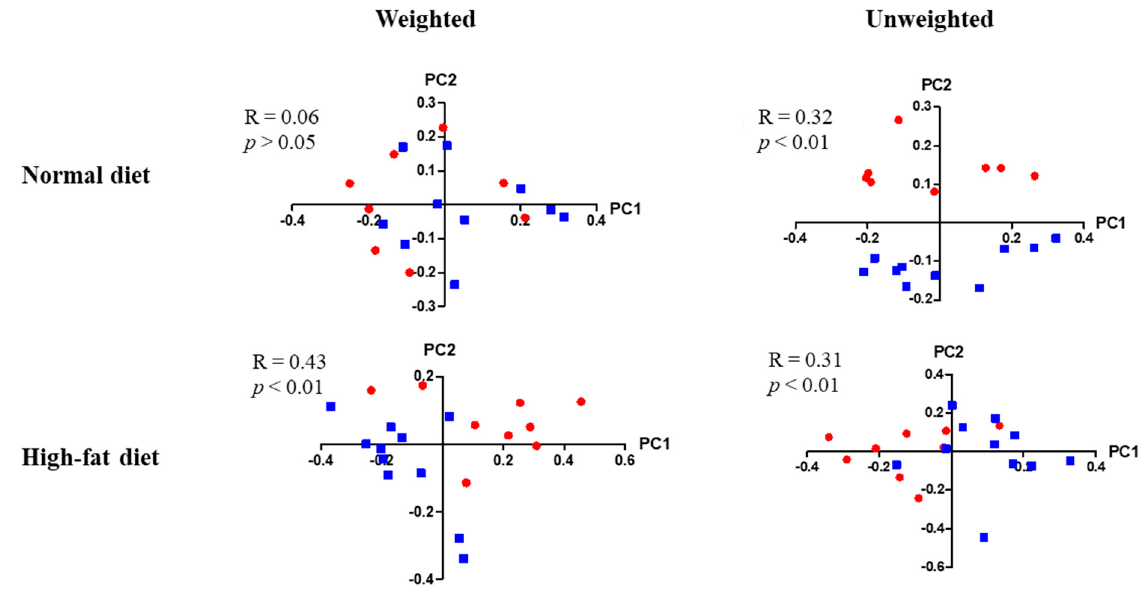
Figure 7. Enteric bacterial populations in young male KO and WT mice. Red circles indicate KO mice, whereas blue squares indicate WT mice. For mice fed a normal diet, n = 8 KO mice, and n = 10 WT mice. For mice fed a high-fat diet, n = 9 KO mice, and n = 11 WT mice. Correlation coefficients and p -values are shown in the figure.